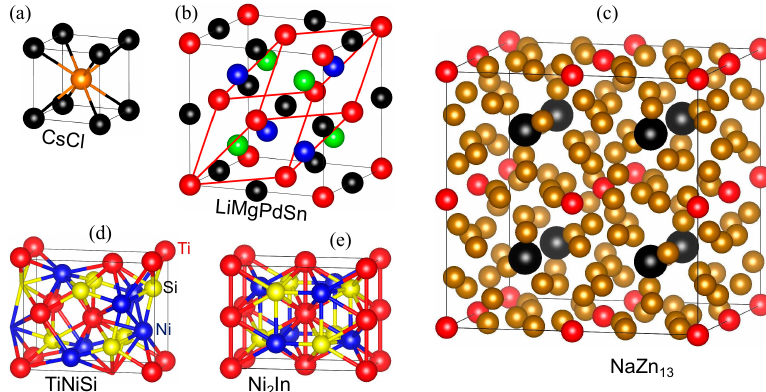
Figure 3. Crystal structures: ( a ) cubic CsCl-type binary B2 (with nearest-neighbor bonds); ( b ) LiMgPdSn-type quaternary Heusler (red lines show 4-atom primitive unit cell); ( c ) cubic NaZn 13 -type La(Fe,Si) 13 (La is black, Fe 1 is red, Fe 2 sites occupied by Fe+Si are orange); ( d ) TiNiSi-type orthorhombic ternary structure; and ( e ) Ni 2 In-type hexagonal structure in orthorhombic supercell (Ni 1 is red, Ni 2 is blue, In is yellow). Images are prepared using VESTA software (https://jp-minerals.org/vesta).